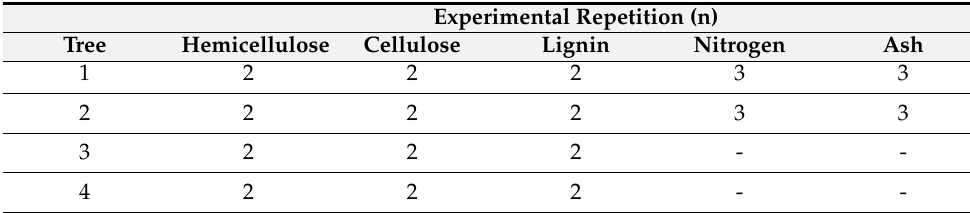
Table 3. Experimental iterations on the four selected trees for each species and each modality combination of the studied variables, i.e., wood and sampling height. Experimental Repetition (n) Tree Hemicellulose Cellulose Lignin Nitrogen Ash 1 2 2 2 3 3 2 2 2 2 3 3 3 2 2 2 - - -